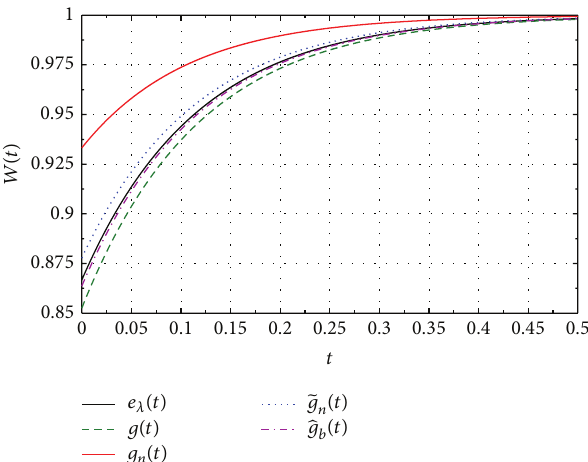
Figure 1: Comparison of waiting times distributions of 𝑀/𝑀/1 and 𝐺/𝑀/1